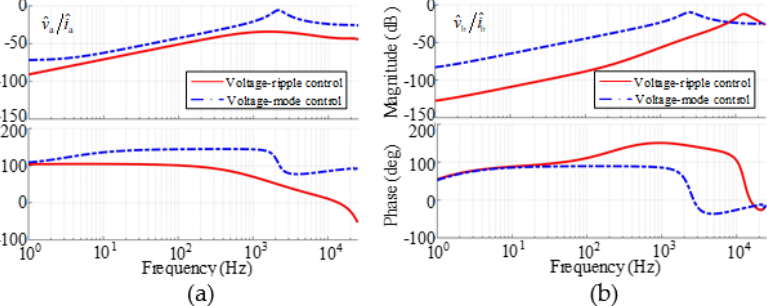
Figure 8. Bode plots of output impedance transfer functions under voltage mode-controlled and voltage ripple-controlled PCCM SIDO buck converters: ( a )